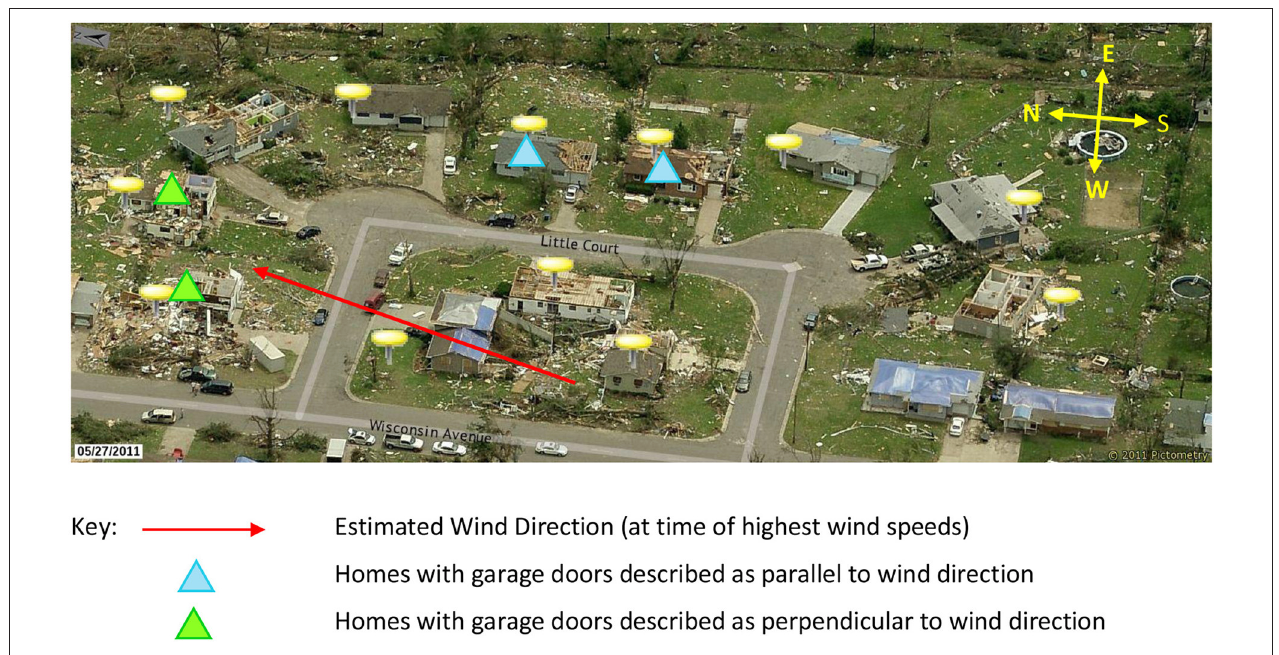
FIGURE 12 | Joplin, MO Home Damage at Various Orientations. Image resolution and quality reduced for publication. Image courtesy of Eagleview Technologies, Inc.